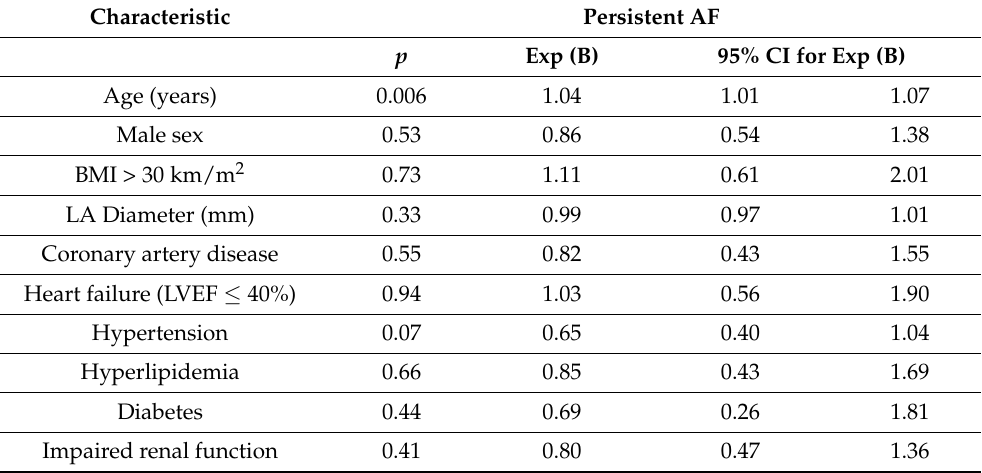
Table 2. Influence of clinical characteristics on primary efficacy endpoint (cox-regression model). Characteristic